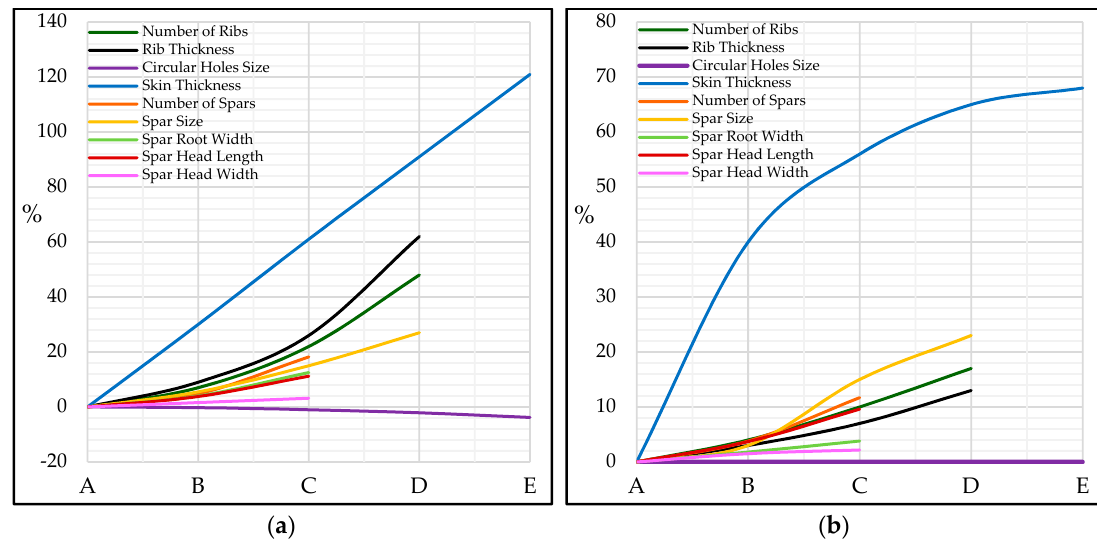
Figure 10. Increment in weight ( a ) and reduction in deformation ( b ) according to the structural configuration.